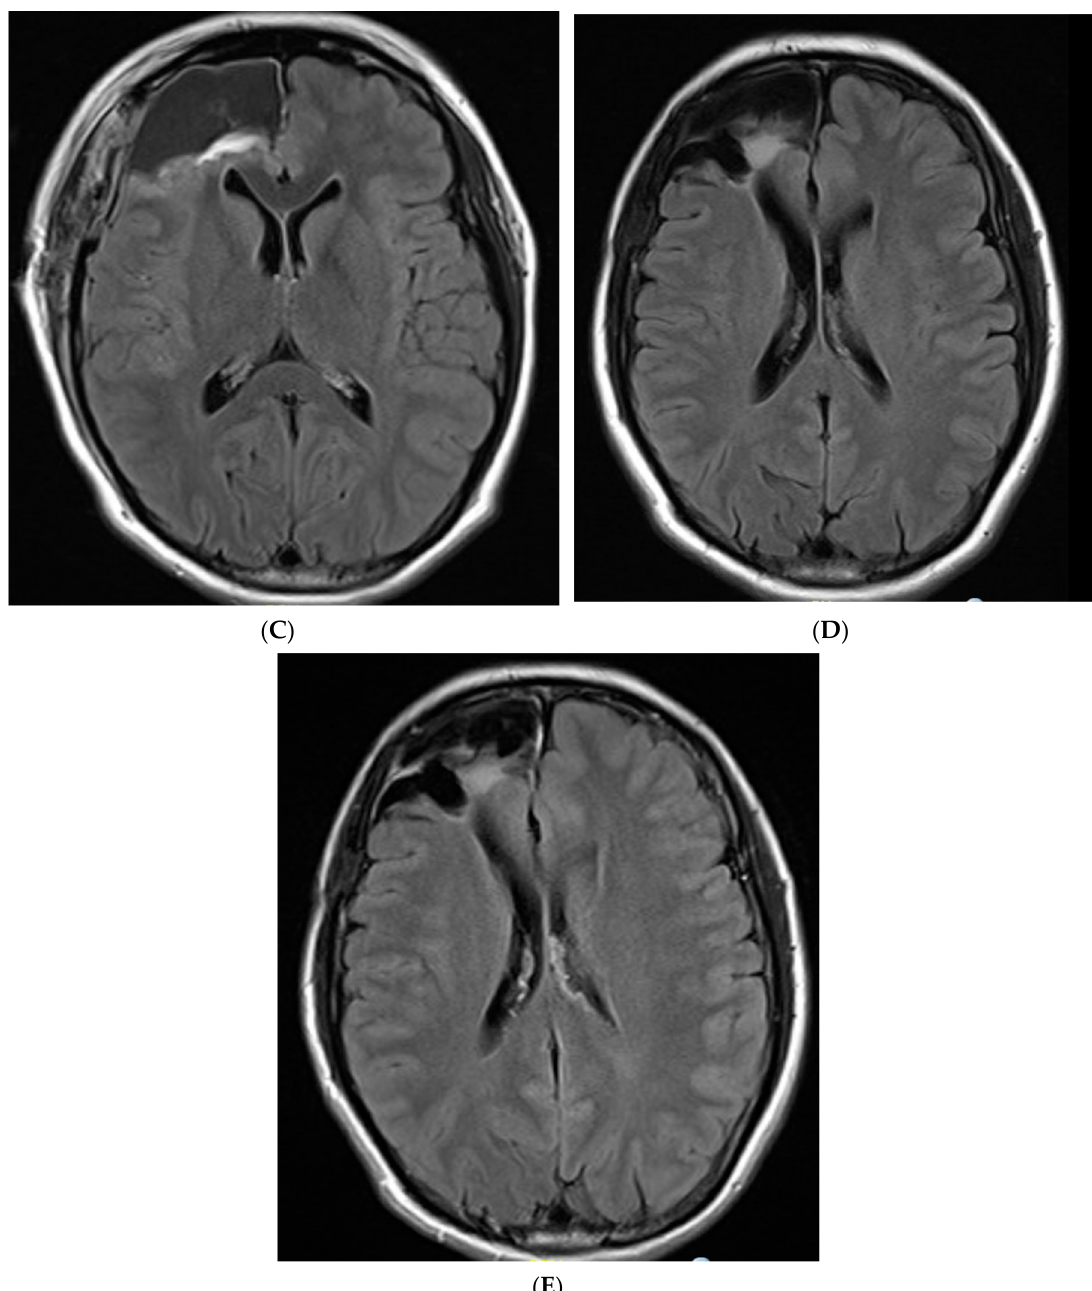
Figure 1. FLAIR sequence axial MRI brain images. ( A ) 2.6 × 2.0 cm lesion in right frontal lobe (pre-operative). ( B ) T1 post contrast pre-operative image of right frontal lobe lesion (pre-operative) ( C ) Hyperintense blood products in resection bed (post-operative day 1), ( D ) Focal area of increased T2/FLAIR signal deep to resection cavity (prior to starting ICI, 9 months after resection). ( E ) T2/FLAIR hyperintense tissue changes in right frontal lobe appear stable (18 months post resection).